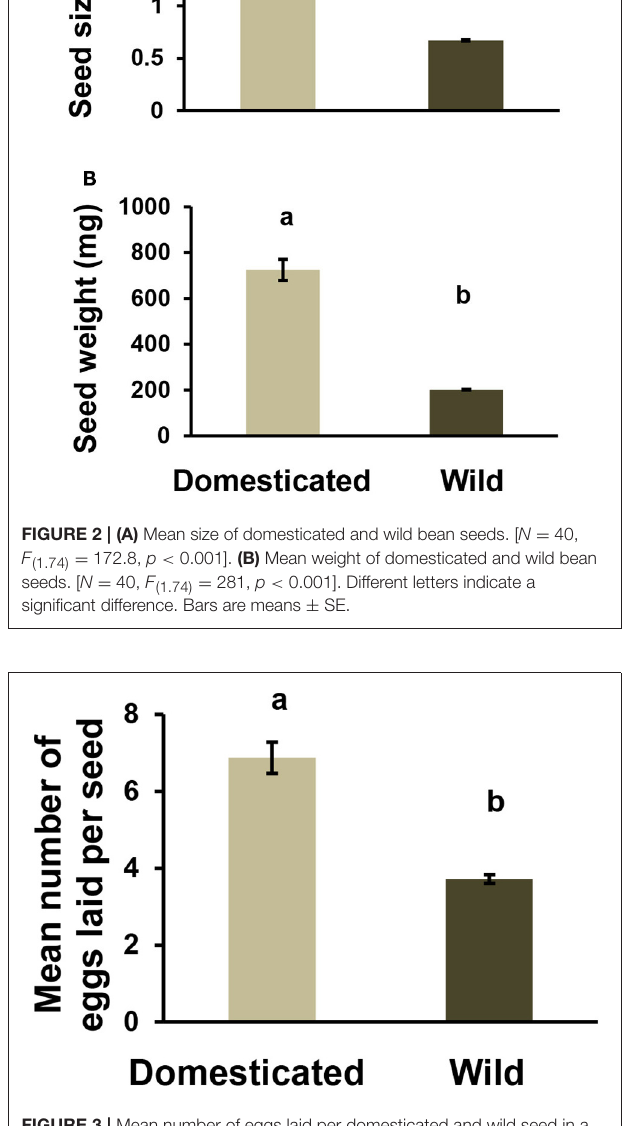
with number of eggs on in wild seeds ( Figure 5B , N = 37, r = − 0.32, p = 0.056) and this correlation was also not significant in cultivated seeds ( Figure 5A , N = 34, r = − 0.018, p = 0.9). Finally, we did not find a difference in the sex ratio of beetles that emerged from domesticated or wild seeds [ F (1.79) = 0.03, p = 0.868; Supplementary Figure 3], nor a significant effect among cultivated varieties or wild populations [ F (4.79) = 0.74, p =